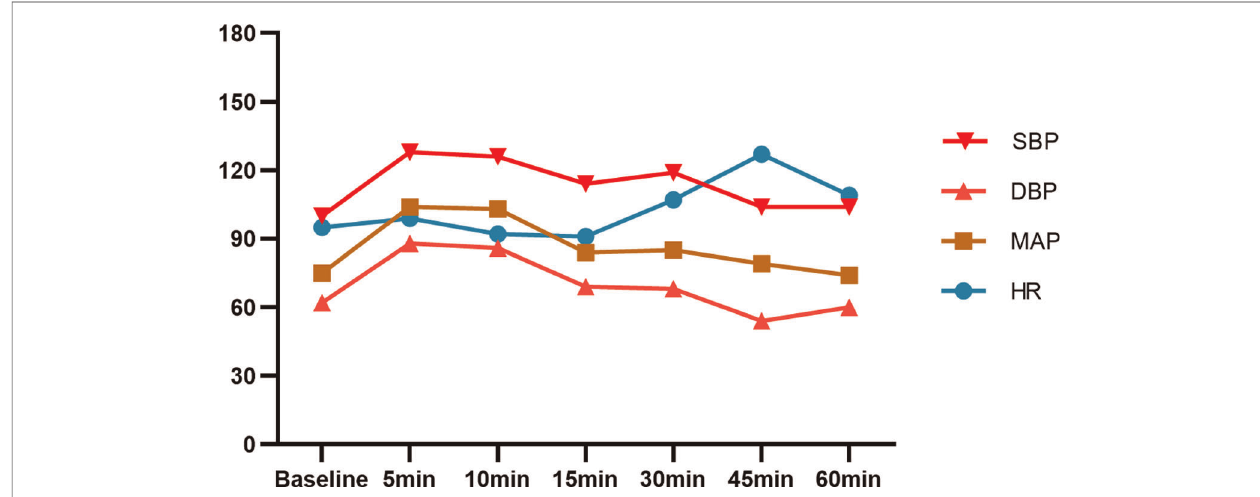
FIGURE 1 | BP and HR of case 1 after epidural anesthesia. SBP, systolic blood pressure; DBP, diastolic blood pressure; MAP, mean artery pressure; HR, hearte